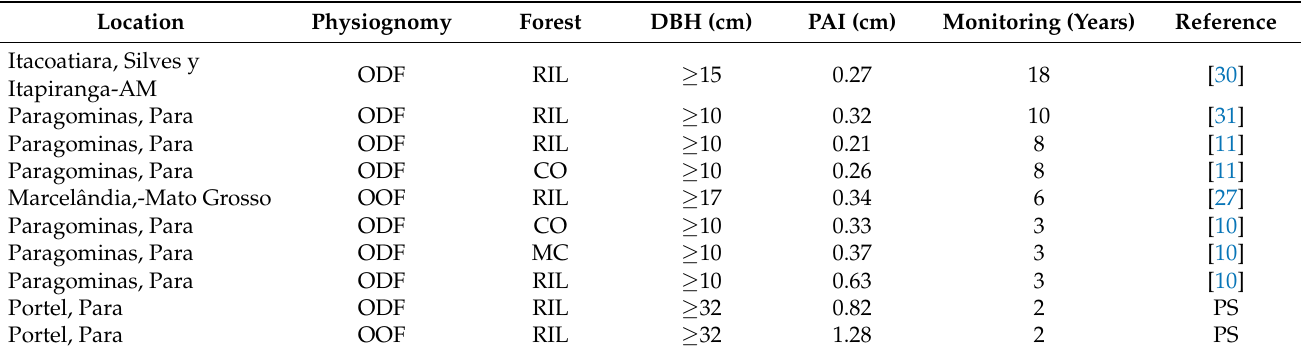
Table 1. Comparison of studies on the periodic annual increment (PAI) for ombrophilous forests in the Brazilian Amazon, considering open and dense